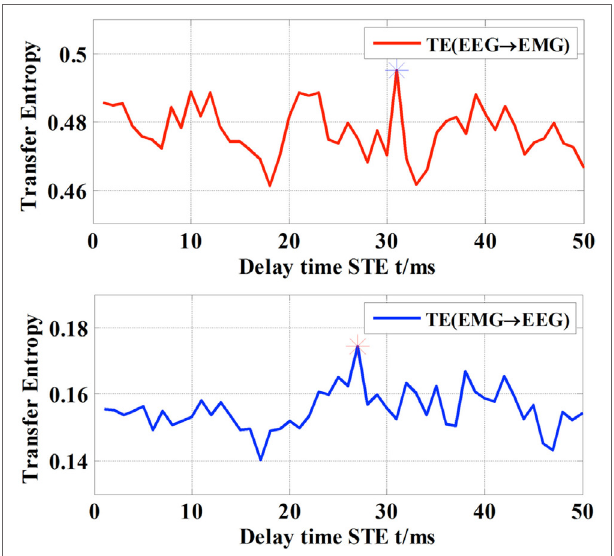
FigUre 3 | Different delay time of TE with respect to the direction of information flow.